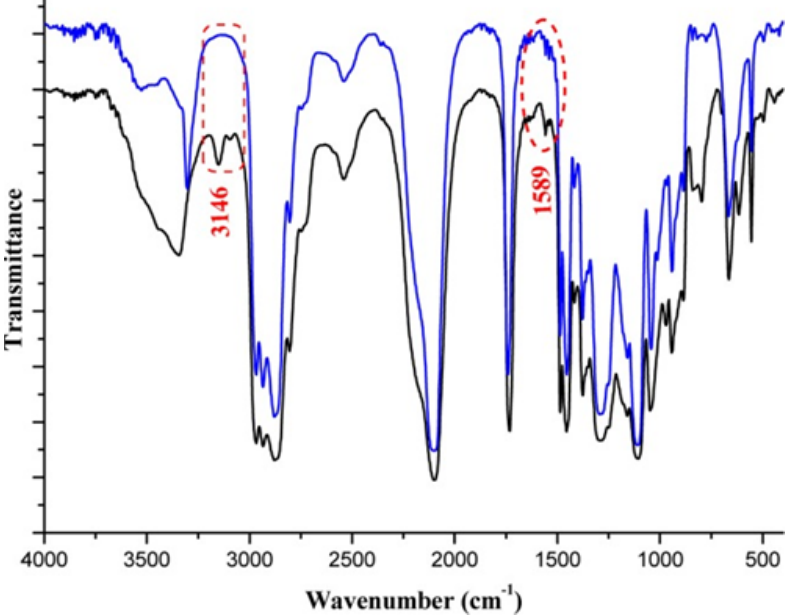
Figure 12. FT-IR spectrum of cross-linked polymer (blue line) and blend of poly(AMMO) and BPHA (black line). Reprinted with permission of John Wiley & Sons from